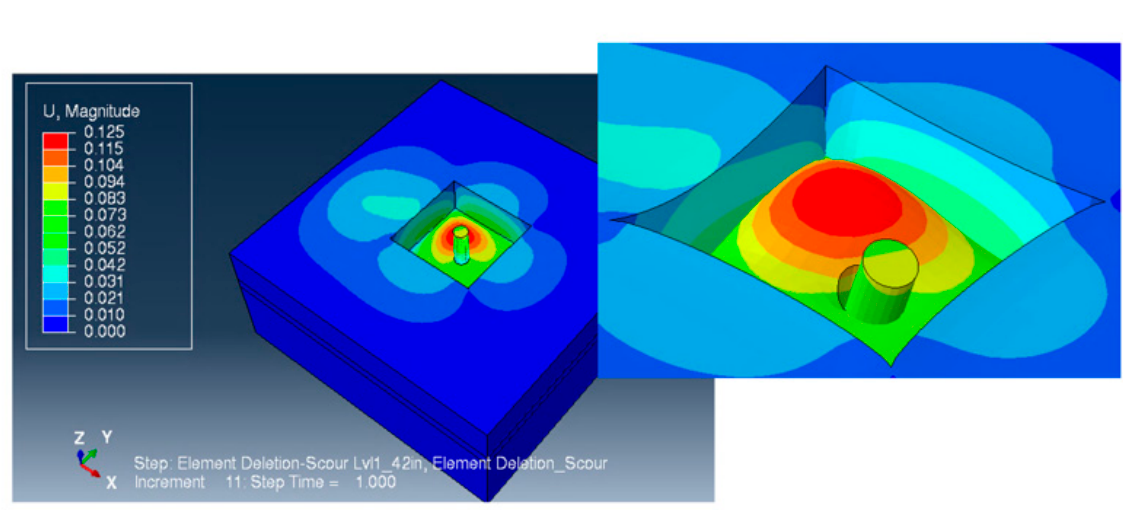
Figure 13. Pile displacements under loading: ( a ) Before scour and ( b ) After scour.